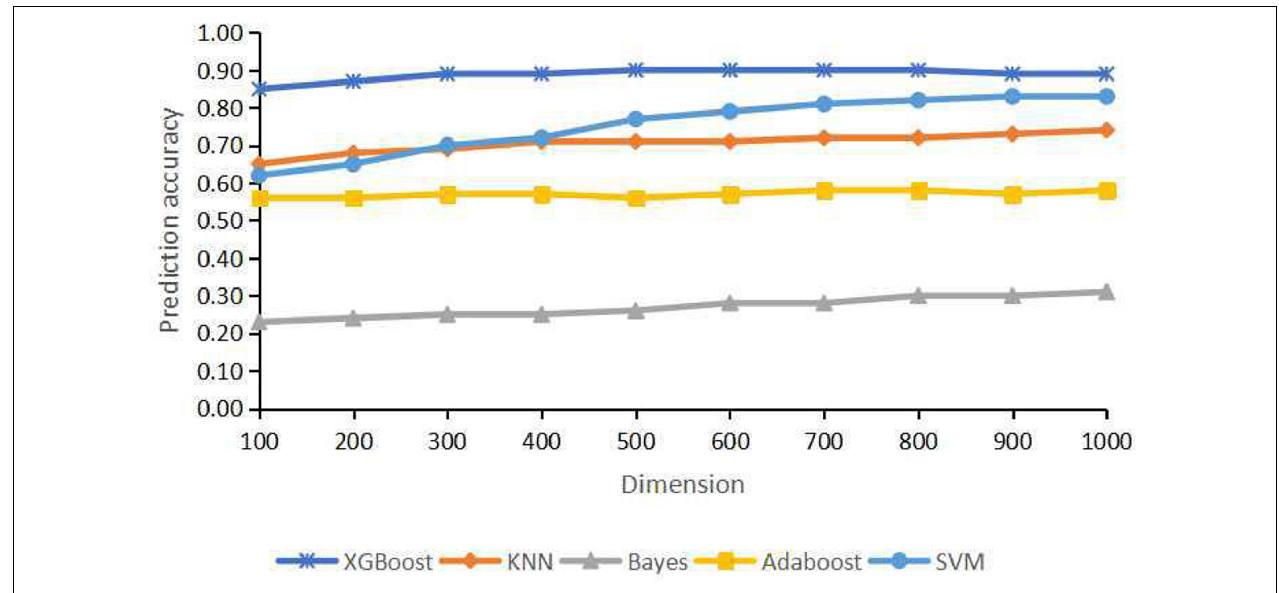
FIGURE 3 | Classification accuracy for different dimensions using extremely randomized tree (Extra tree) and principal component analysis (PCA).